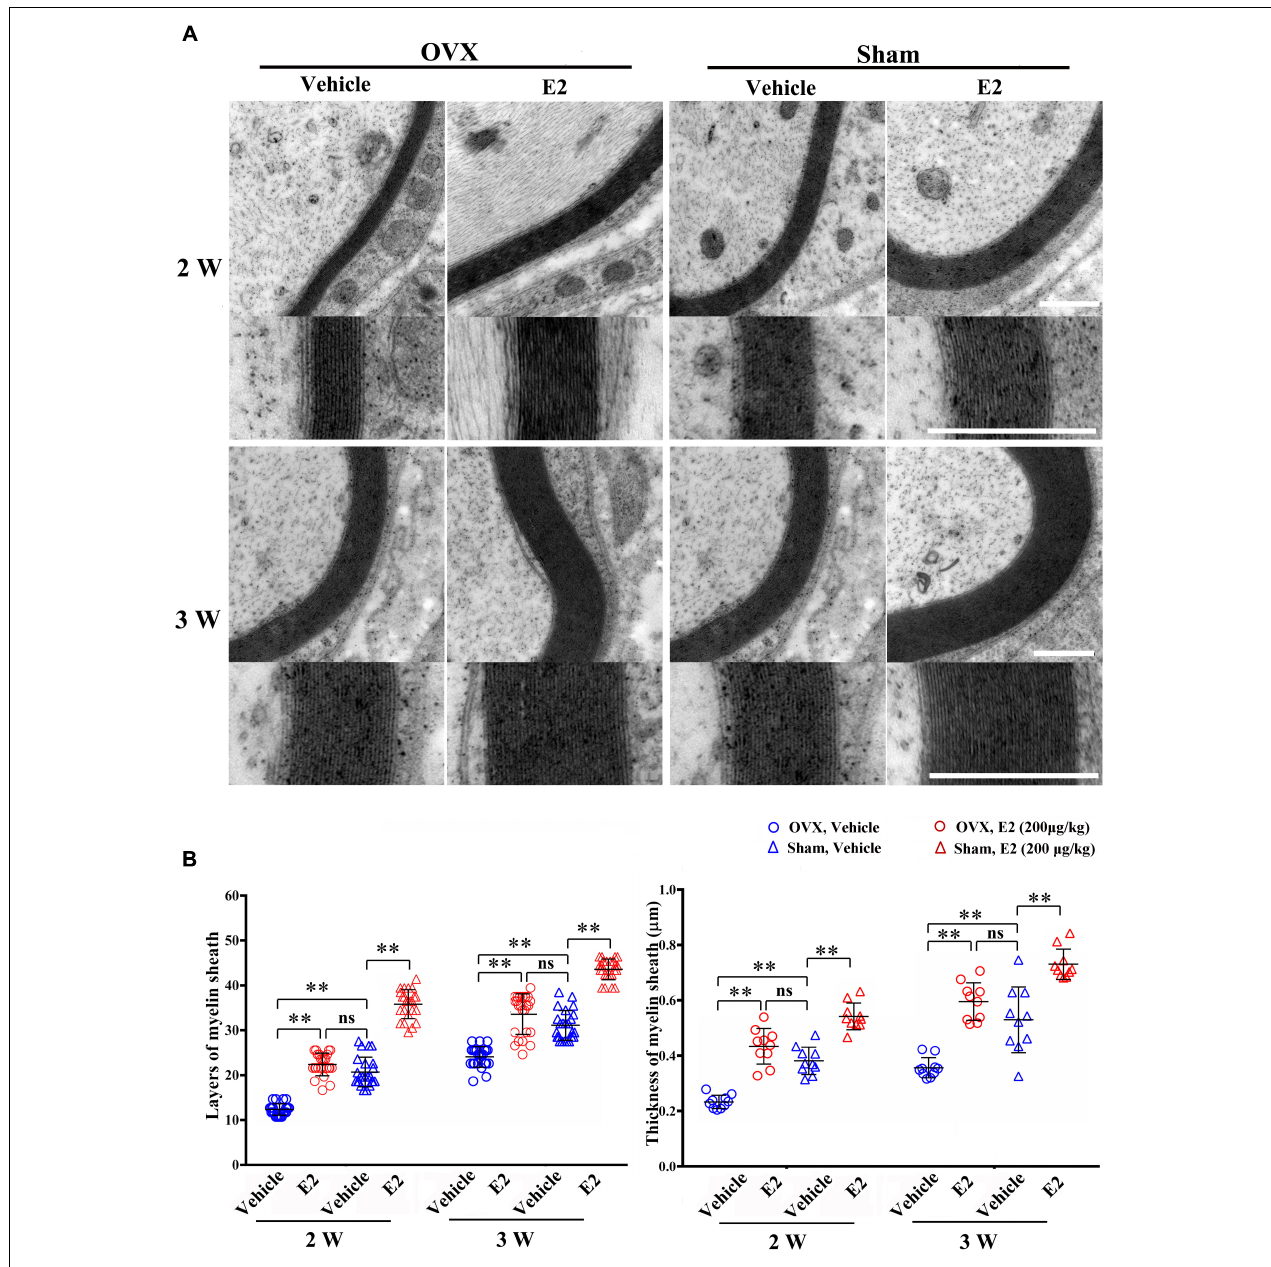
FIGURE 7 | E2 promotes axon remyelination in regeneration sciatic nerve. (A) Representative transmission electron micrographs, obtained at 2 and 3 weeks post-surgery, of regenerated nerve in the OVX, OVX treated with E2, sham, sham treated with E2 groups, scale bar, 0.6 µ m. (B) Histograms comparing the number of myelin sheath layers and the thickness of the myelin sheath among the OVX, OVX treated with E2, sham, sham treated with E2 groups. ∗∗ p < 0.01 versus vehicle. Two-way ANOVA, n = 5 rats per group. All the data are mean ± SEM.